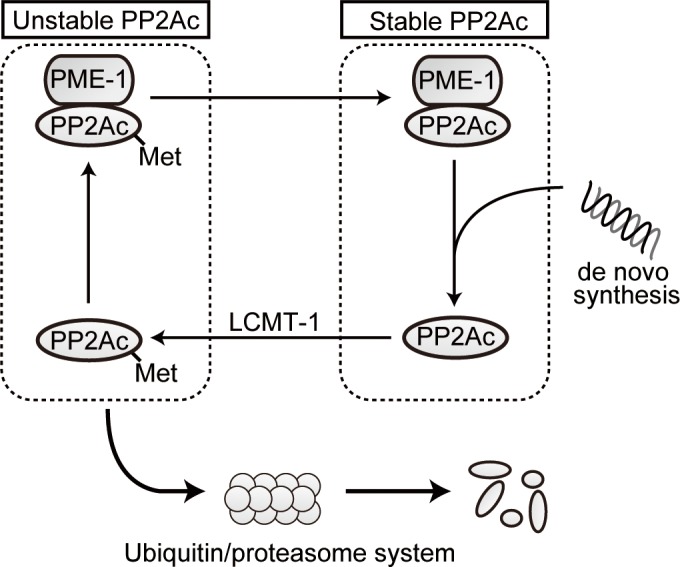
Proposed working hypothesis.Proposed working hypothesis for the regulatory mechanism for PP2A protein level by PME-1. See the Discussion for details.